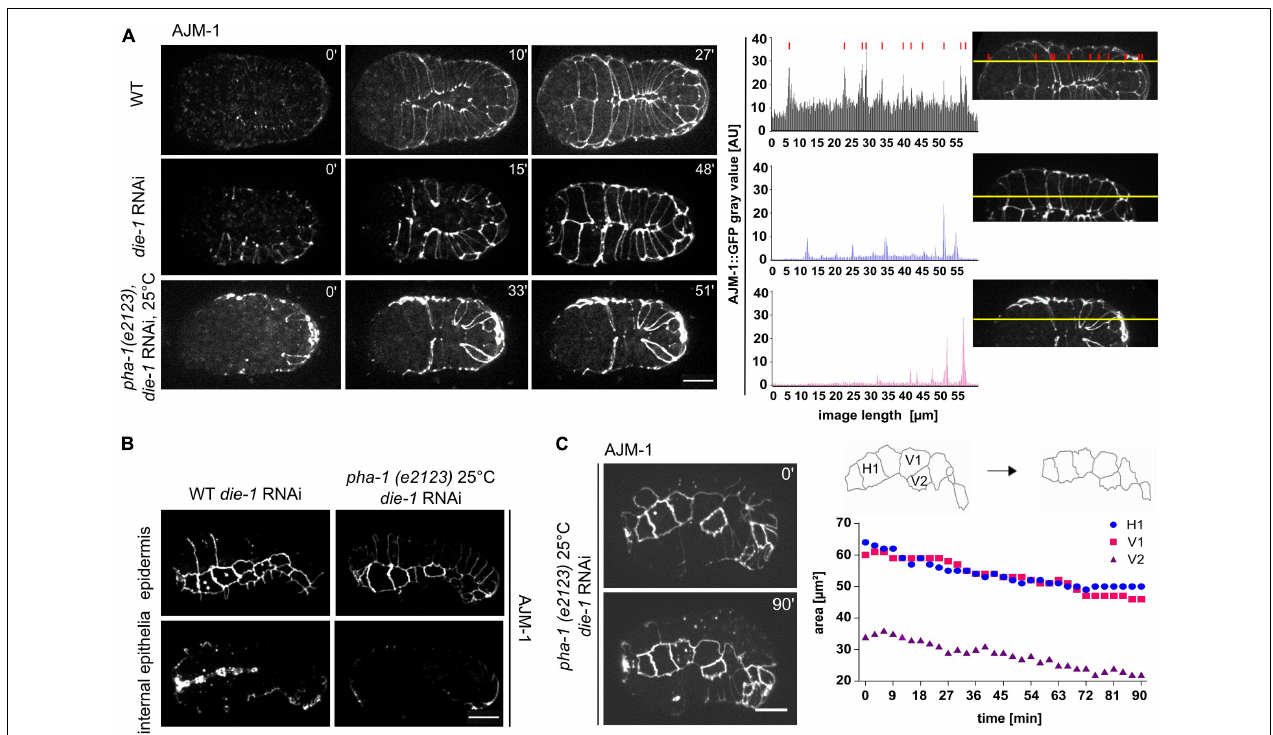
FIGURE 4 | die-1 RNAi epidermal phenotypes and their exacerbation by pha-1(e2123) . (A) Left: comparison of ventral enclosure in WT (with or without die-1 RNAi) and pha-1(e2123) embryos. WT embryos exposed to die-1 RNAi show delayed ventral enclosure due to disorganized migration of contralateral ventral epidermal cells. Note that pha-1(e2123) shows unequal expression of AJM-1::GFP in ventral epidermal cells. Right: plot profiles of AJM-1::GFP signals of embryos depicted in the top panel. Yellow lines represent ROIs used for the plot profile. Red lines mark peaks of cell boundary signals. Background signals are indicated through solid black lines in the plot profile. Scale bar, 10 µ m. (B) Comparison of the impact of pha-1 and die-1 on internal and external epithelia. The top pictures show surface (epidermis) signals, bottom pictures show internal (pharynx) signals for AJM-1; scale bar, 10 µ m. (C) Quantification of changes in cell surface area of single seam cells throughout time following die-1 RNAi. Left panel: stills of seam cells of die-1 RNAi embryos. Note that embryos do not elongate, and seam cells show changes in shape. Right panel top: schemes of changes in cell shape of seam cells depicted in left panel. Right panel bottom: quantification of cell surface of single seam cells (H1, V1, and V2) of the embryo shown in the left